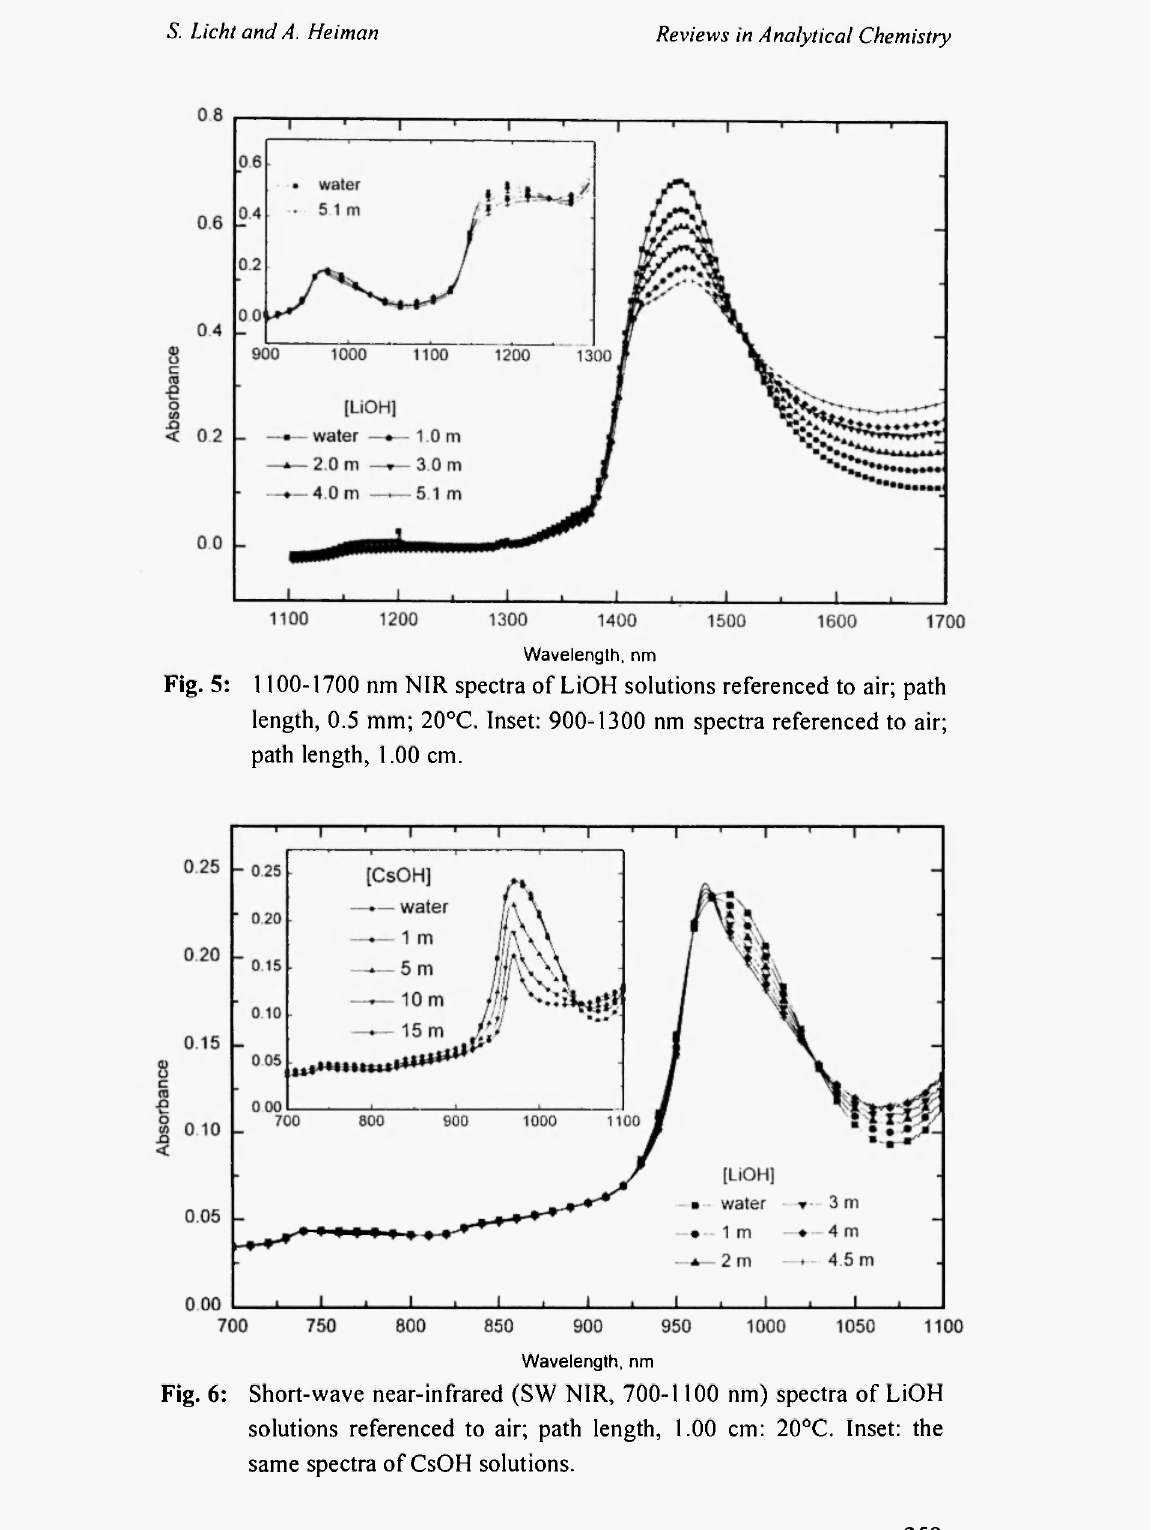
Fig. 6: Short-wave near-infrared (SW NIR, 700-1100 nm) spectra of LiOH solutions referenced to air; path length, 1.00 cm: 20°C. Inset: the same spectra of CsOH